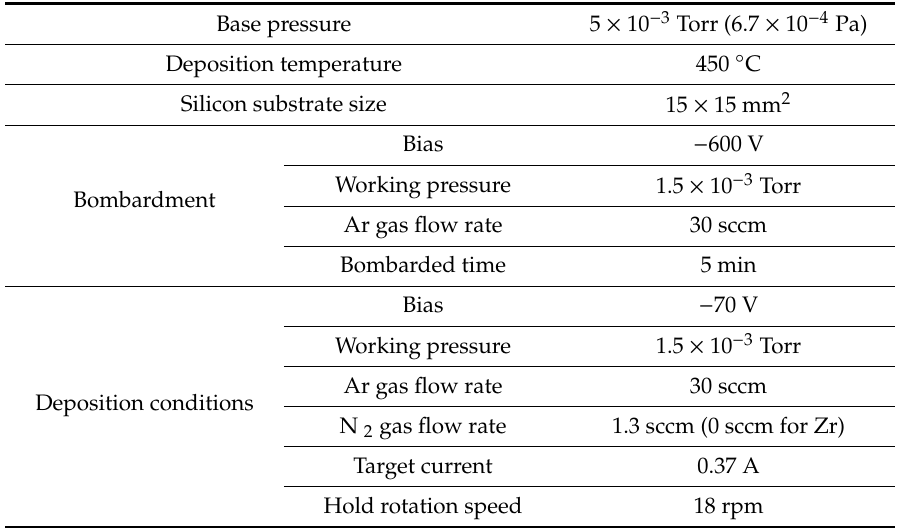
Table 2. The deposition conditions of ZrN thin films.